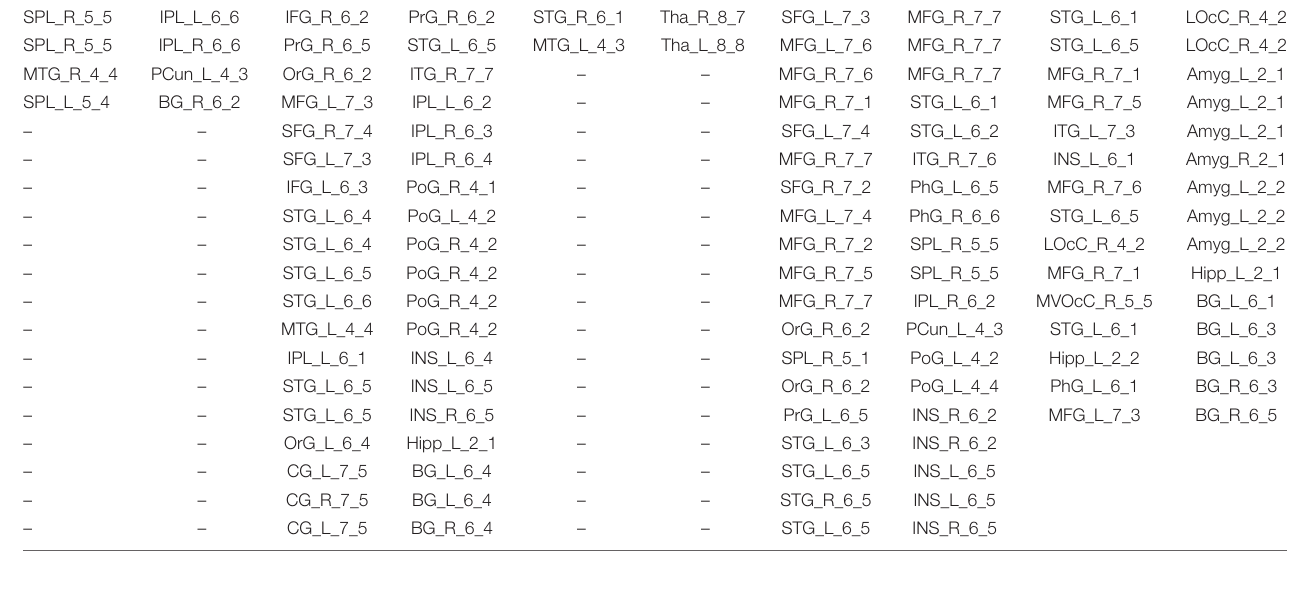
TABLE 3 | Differences in static functional connectivity with global signal regression. AVHs and non-AVHs AVHs and NC Non-AVHs and NC Region 1